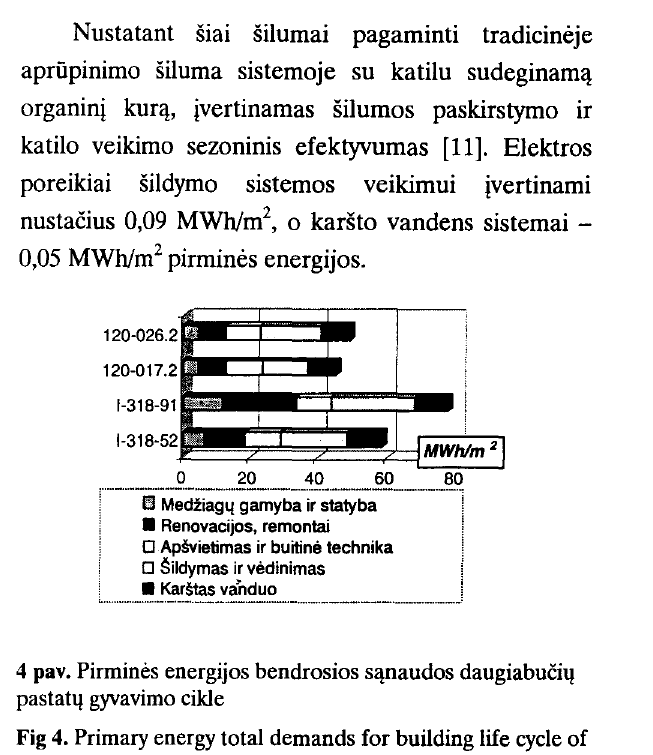
Fig 4. Primary energy total demands for building life cycle of dwelling